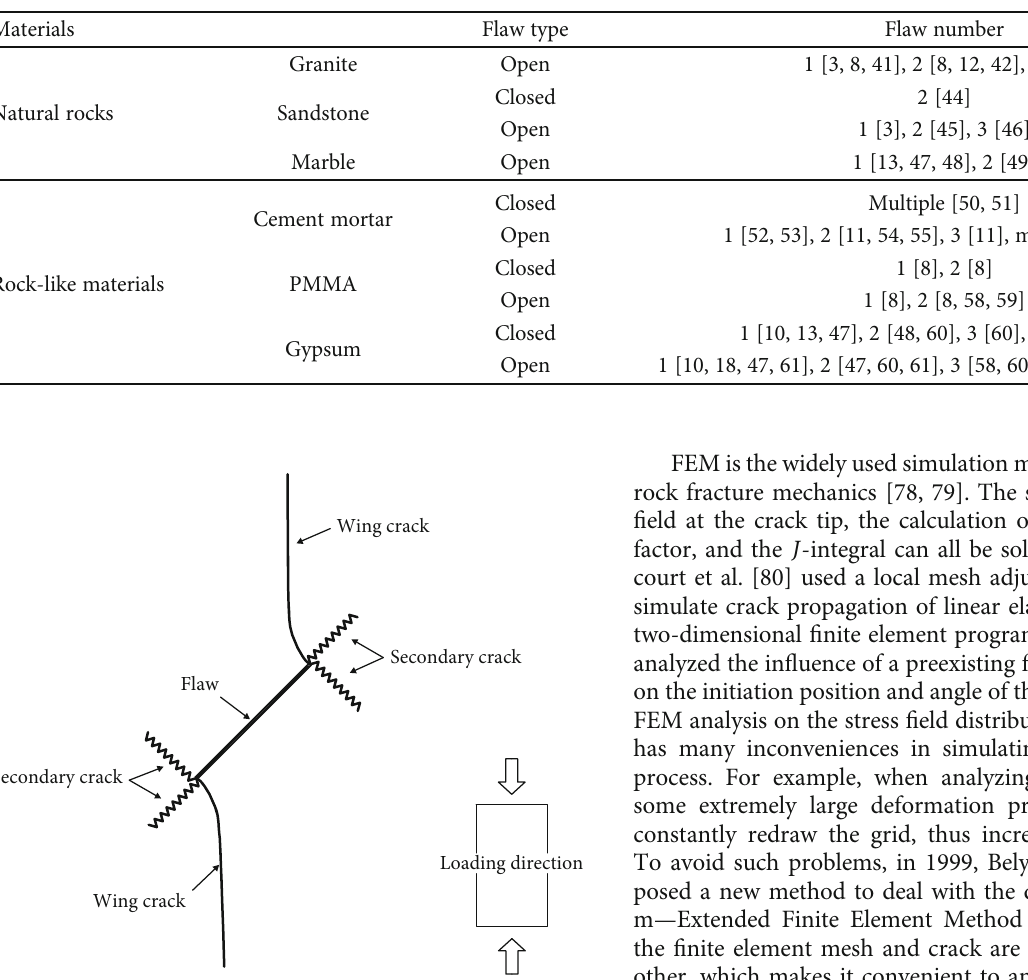
Table 1: Di ff erent kinds of specimens for rock fracture test.